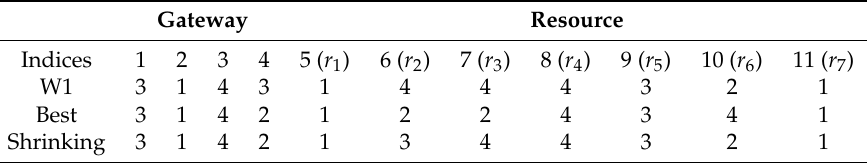
Table 5. An example shrinking function.